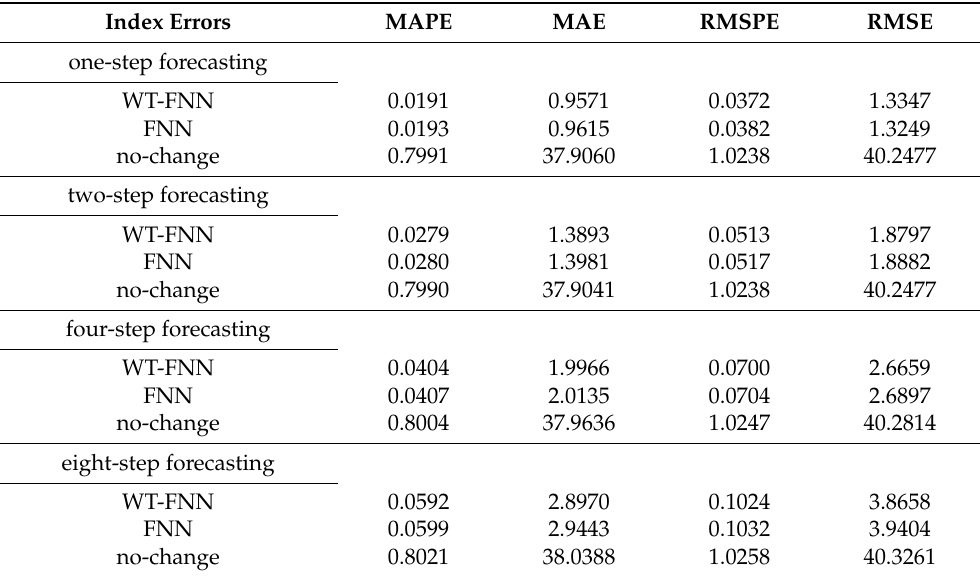
Figure 4. Comparisons of the predictive data and the actual data for the WT-FNN model. ( a ) one-step; ( b ) two-step; ( c ) four-step; ( d ) eight-step. Table 2. Comparisons of predictions from different forecasting